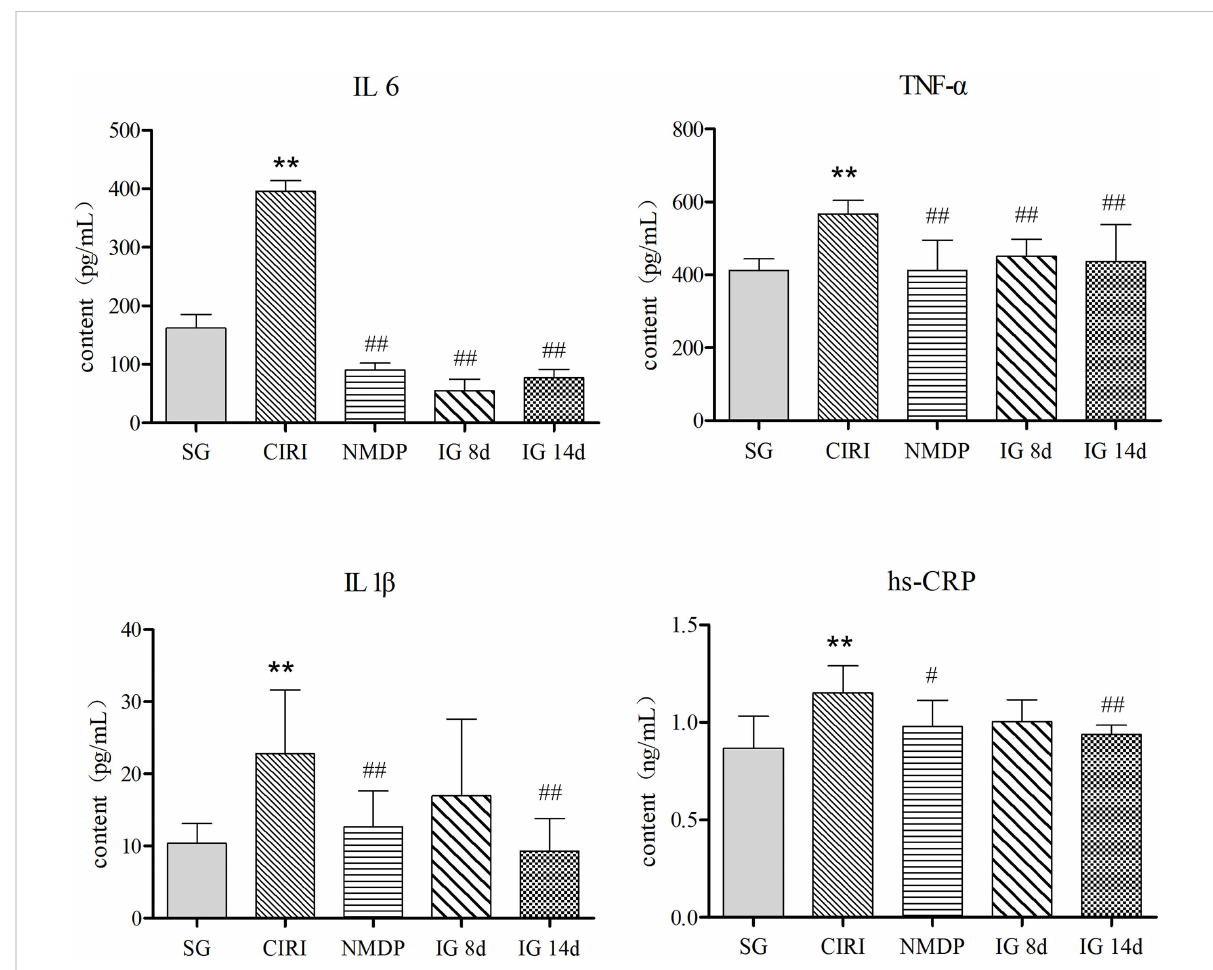
FIGURE 3 In fl ammatory factor content in the serum. Compared with the SG, *P < 0.05, **P < 0.01; compared with the CIRI group, # P < 0.05, ## P < 0.01. conspicuously higher ( Proteobacteria : 17.63% abundance in the SG, 25.21% abundance in CIRI, P < 0.01). At the gene level (Figure 6B), Shigella in the intestinal microorganisms of the CIRI group was conspicuously higher than that of the SG. Proteobacteria and Shigella in the NMDP, IG 8d, and IG 14d groups showed a trend toward a return to levels observed in the SG.